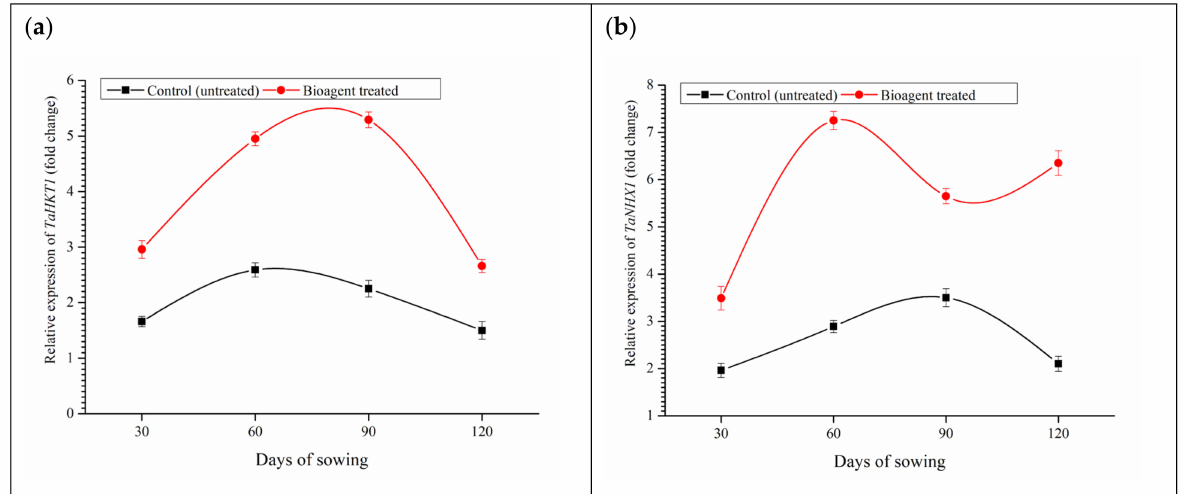
Figure 6. Effects of microbial inoculation on expression profile of ( a ) TaHKT-1 and ( b ) TaNHX-1 in the wheat grown in saline sodic soil at 90 DAS. Data are means and vertical bar represents standard